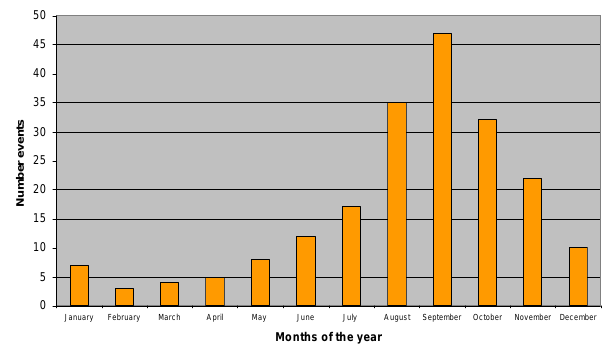
Figure 3. Monthly distribution of flood events recorded in Catalonia (1982-2007) Fig. 3. Monthly distribution of flood events recorded in Catalonia